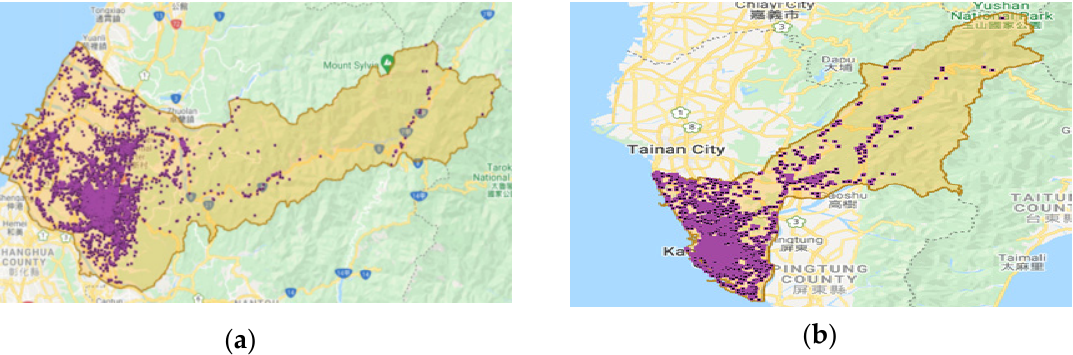
Figure 10. The distribution of targets. ( a ) The distribution of targets in City 2; ( b ) The distribution of targets in City 3.